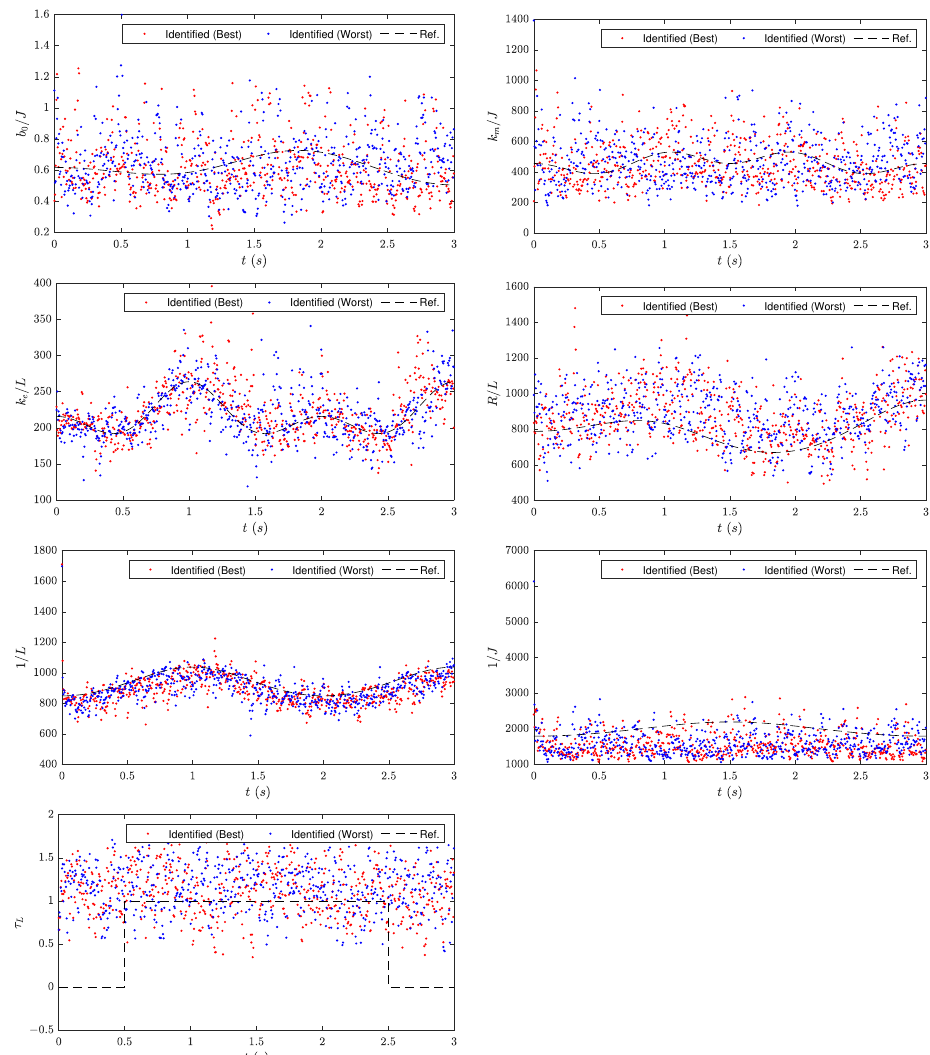
Figure 13. Identified motor parameters for the best and worst runs of CATSCG considering